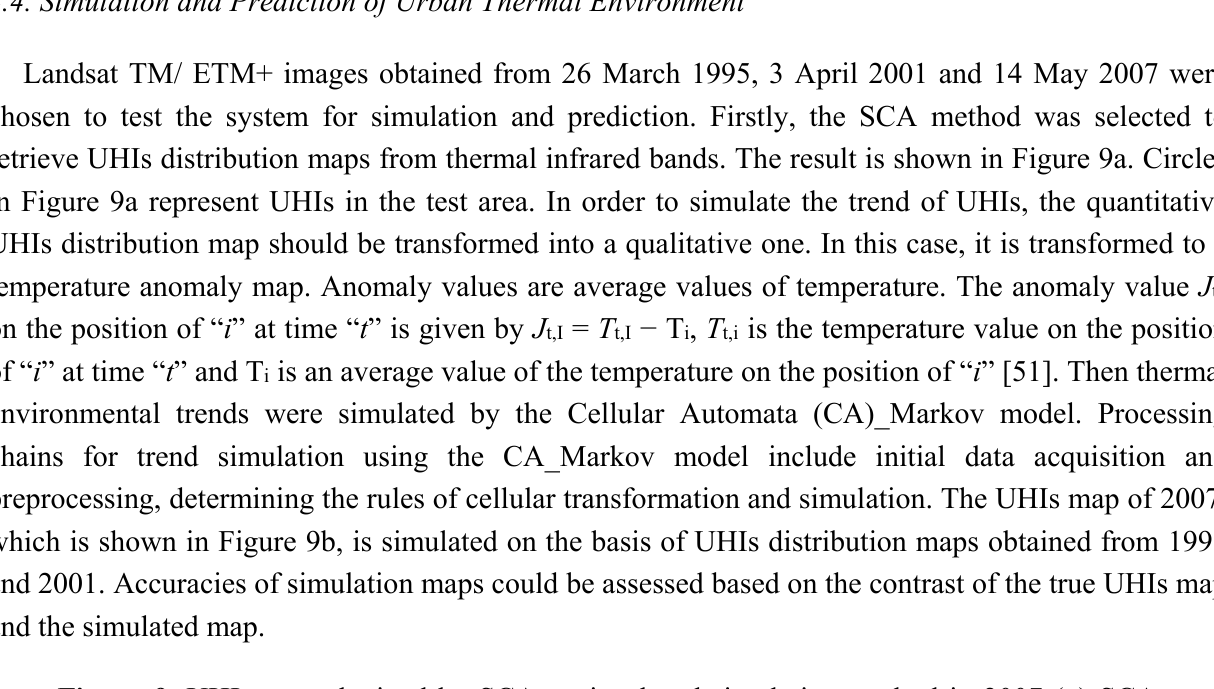
Figure 9. UHIs map obtained by SCA retrieval and simulation method in 2007 ( a ) SCA method; ( b ) Simulation